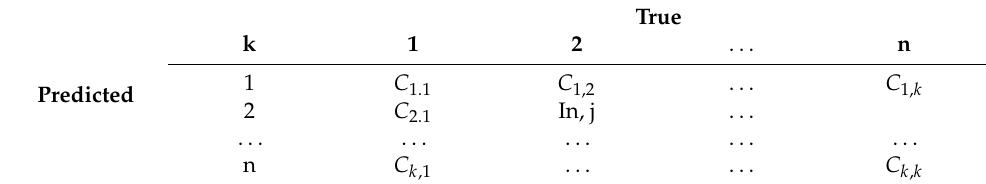
Table 7. Multiclass confusion